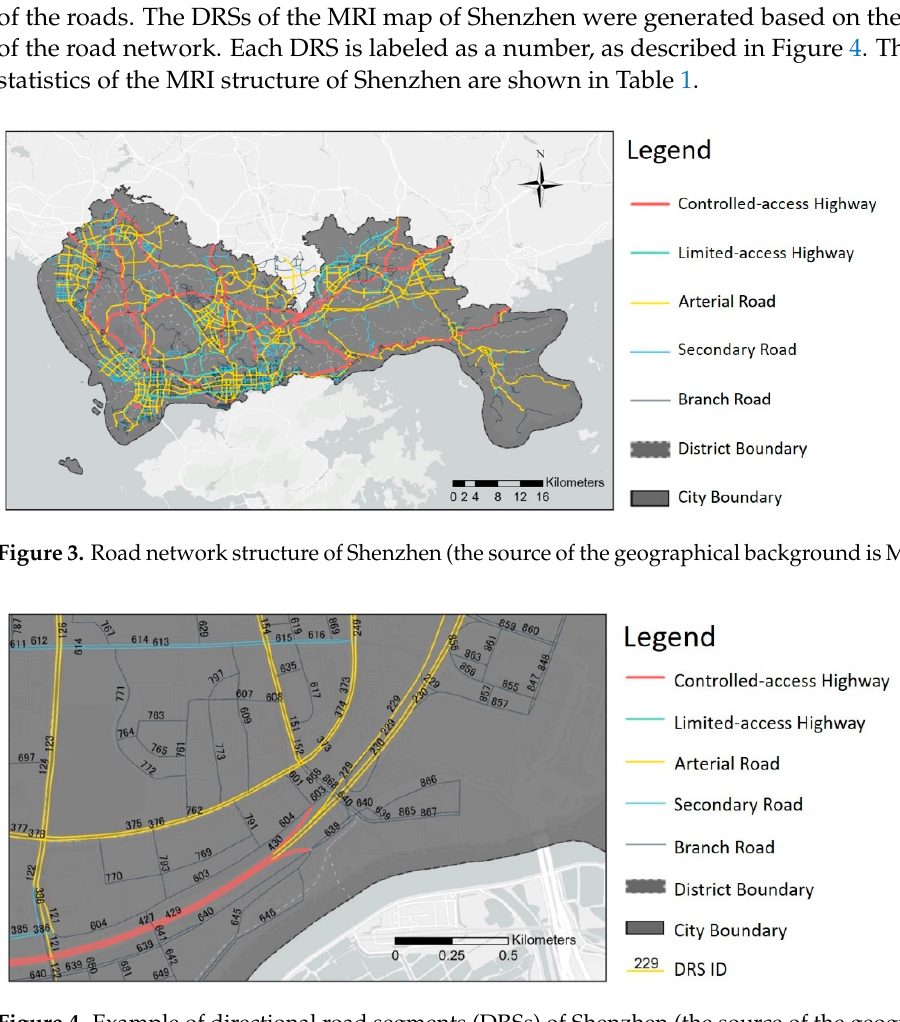
Figure 4. Example of directional road segments (DRSs) of Shenzhen (the source of the geographical background is Mapbox). Table 1. Basic statistics of the MRI system of